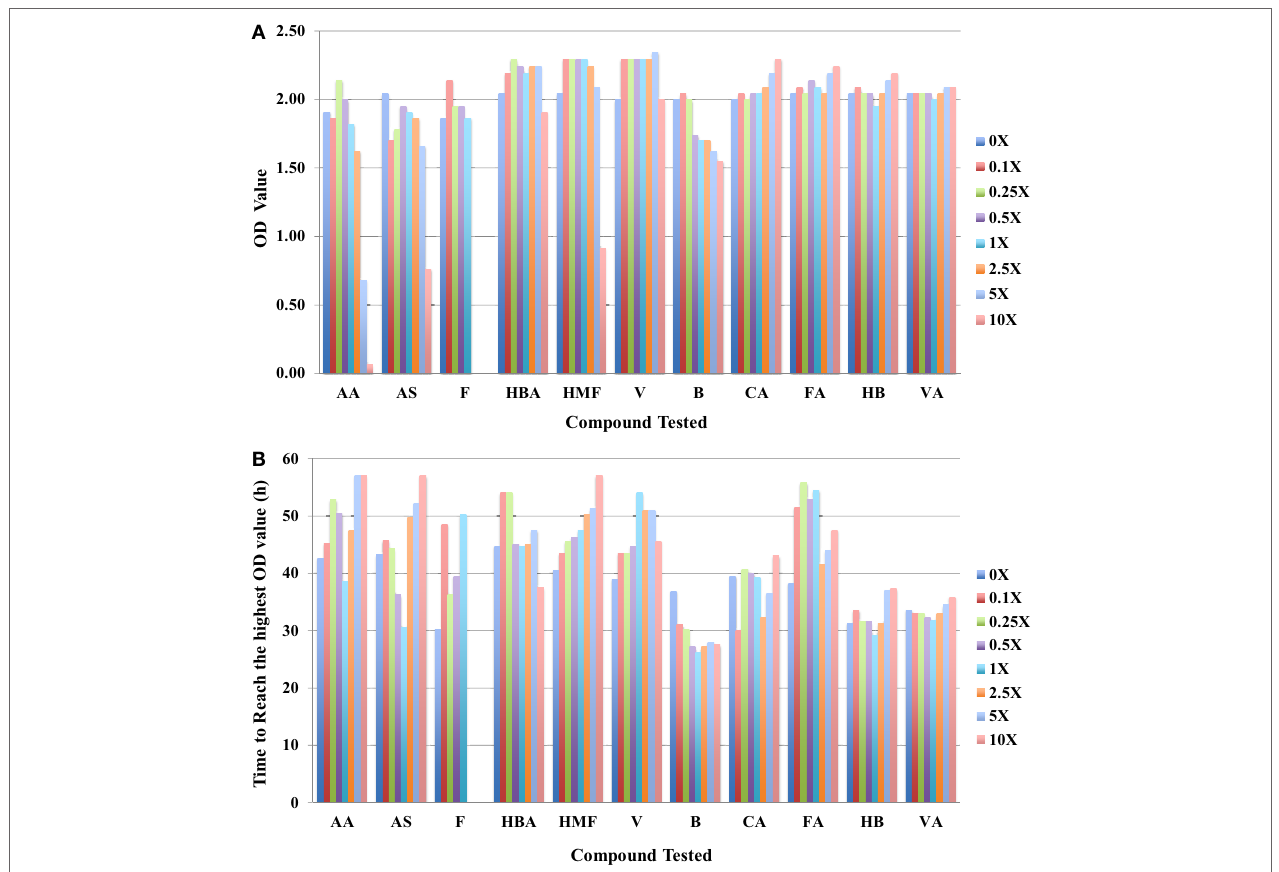
FigUre 2 | The highest OD 420–580nm value that R. opacus PD630 cells can reach (a) and the time to reach the highest OD 420–580nm value (B) to different compounds tested with concentration range from 0 to 10 folds of the one detected in saccharified slurries. Growth was monitored using the Bioscreen C instrument with three technical replicates. The experiments were repeated at least two times with similar